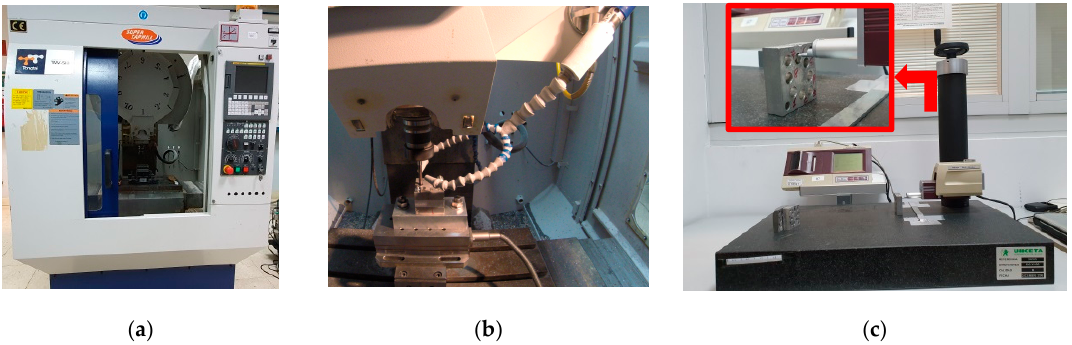
Figure 2. ( a ) Tongtai TMV510 machining center; ( b ) details of the Vortec Cold Air Gun during the trials; ( c ) Mitutoyo Surftest SJ 401 roughness tester.